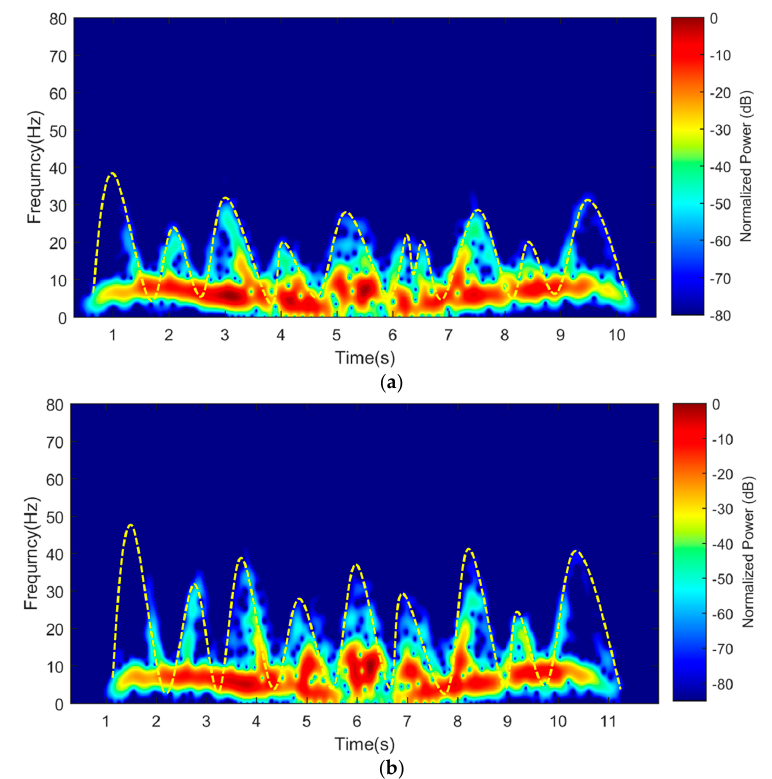
Figure 17. Spectrogram for one pendulum that starts moving in a forward motion when the release angles, θ 0 at: ( a ) 40 ◦ ; and ( b ) 70 ◦ .